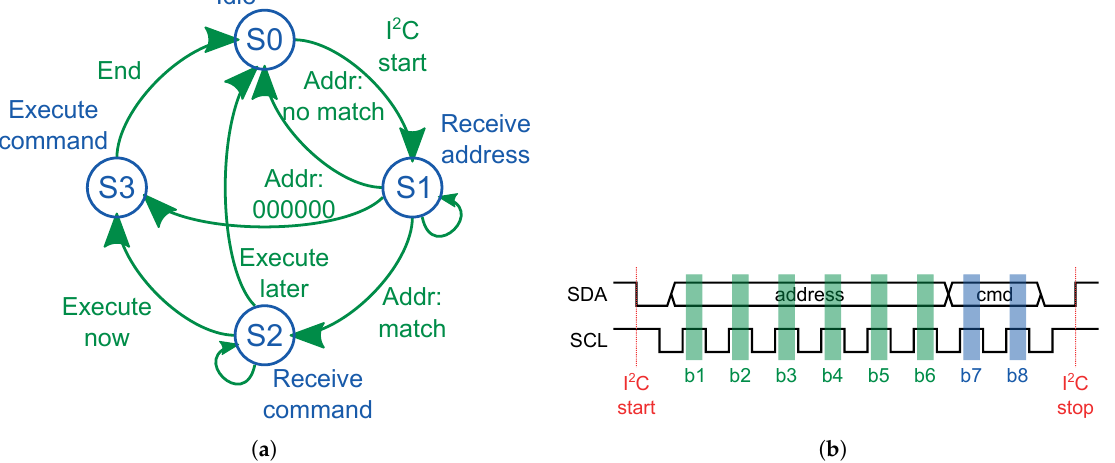
Figure 5. The DataProc is written as a state machine. Transitions between the states depend on the received data. ( a ) The state machine in DataProc . ( b ) Schematic representation of the I 2 C based communication